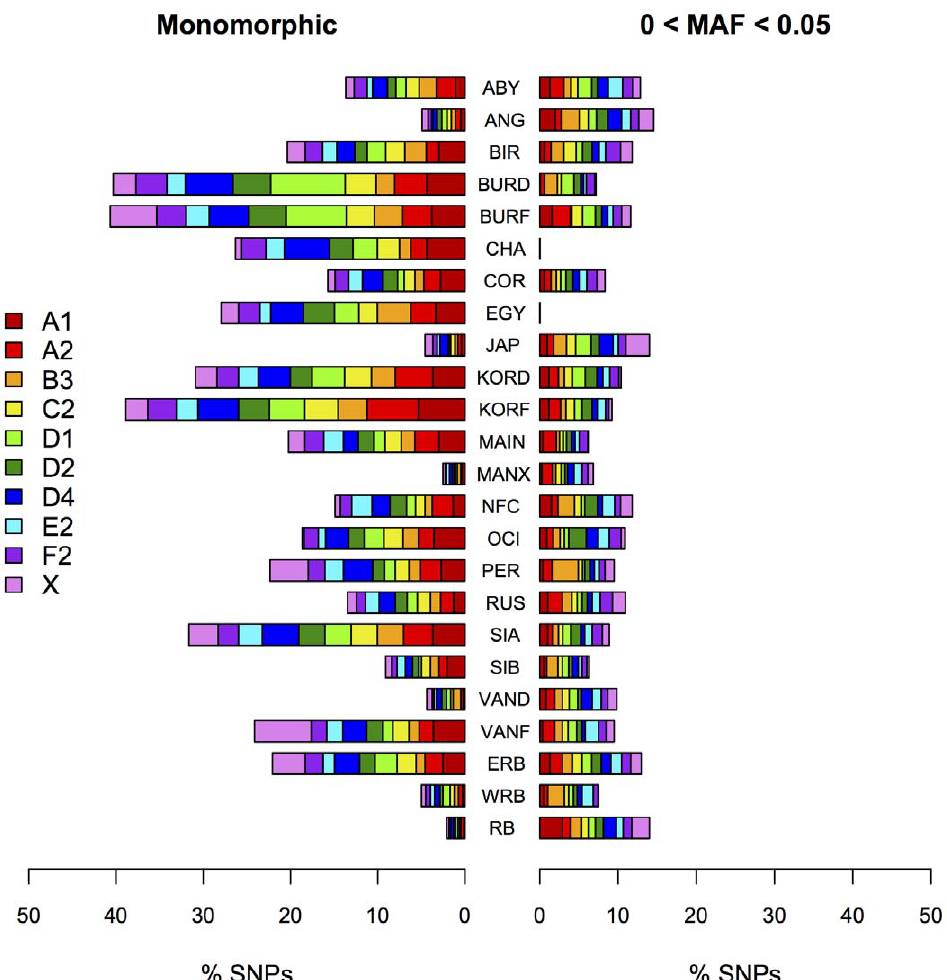
Figure 1. Population based SNP analysis of the domestic cat. Number of monomorphic SNPs (left) and SNPs with a minor allele frequency 0 , MAF , 0.05 (right). Legend corresponds to the ten chromosomal regions.